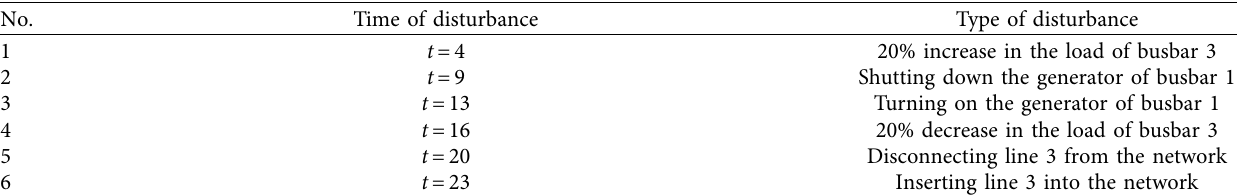
Table 3: Disturbances on the 3-bus network at diferent times.